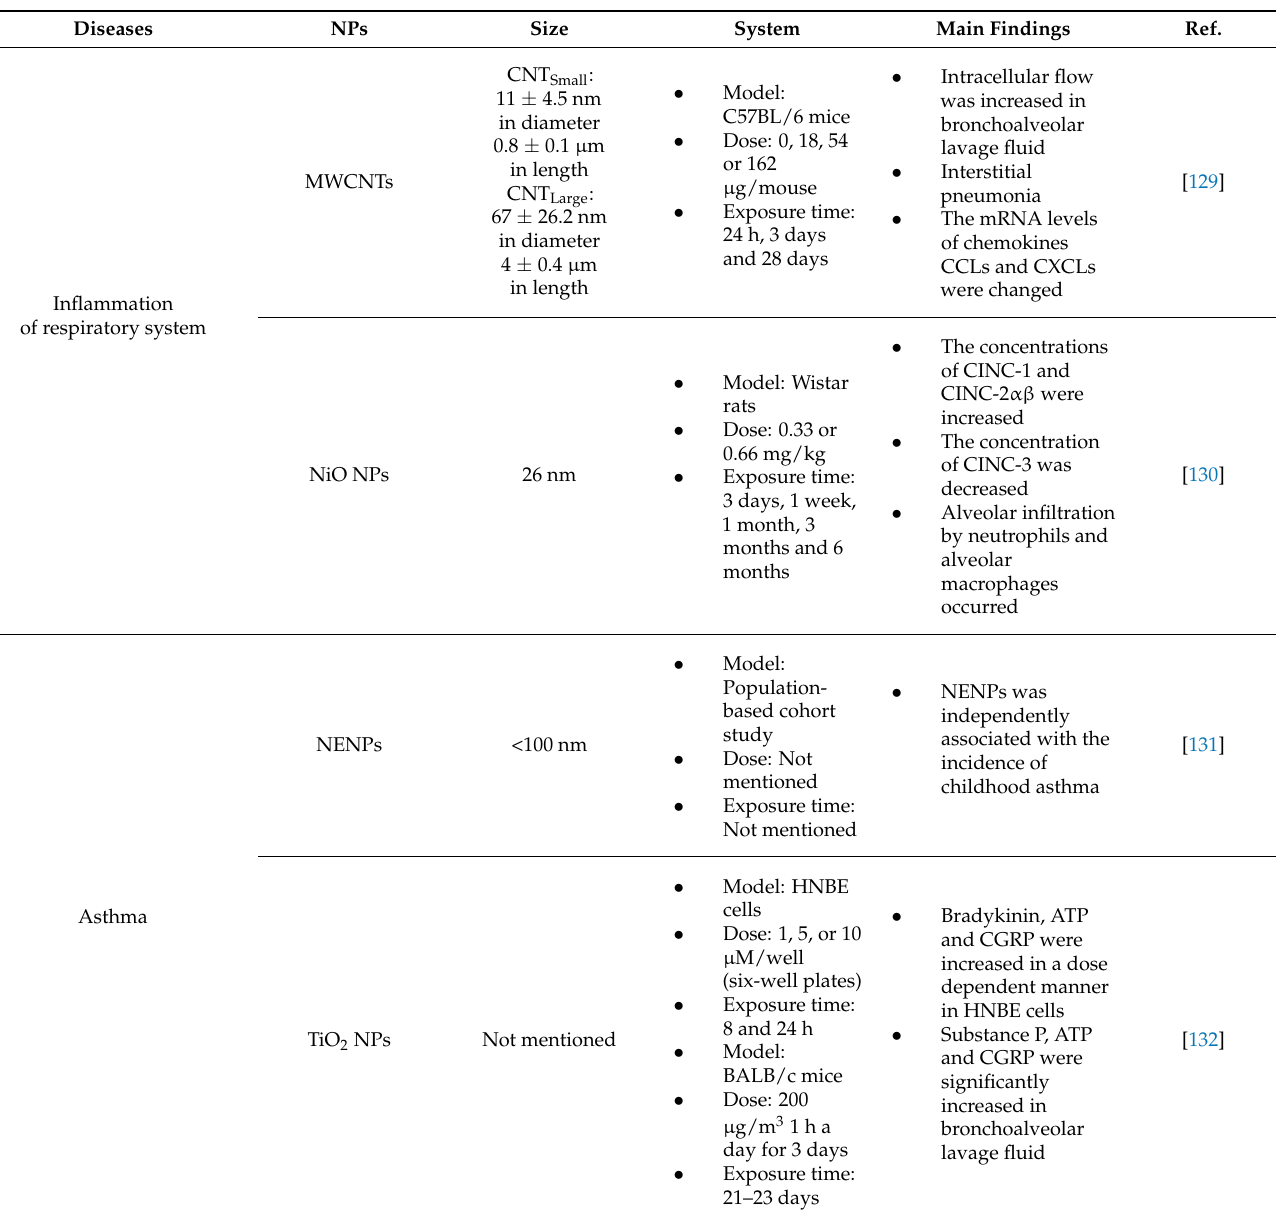
Table 2. Studies on diseases caused by